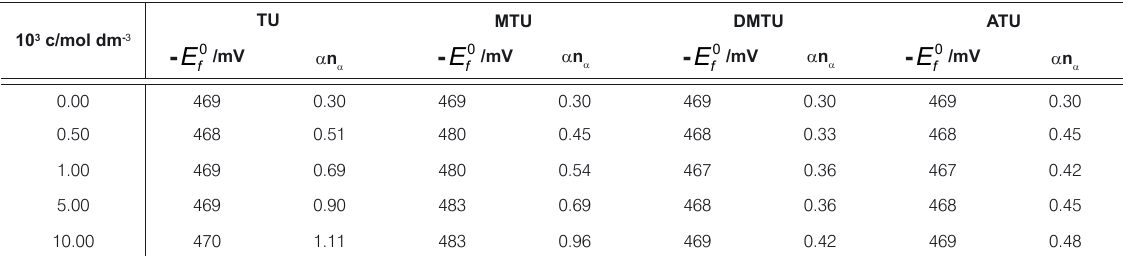
Table 2. Values of formal